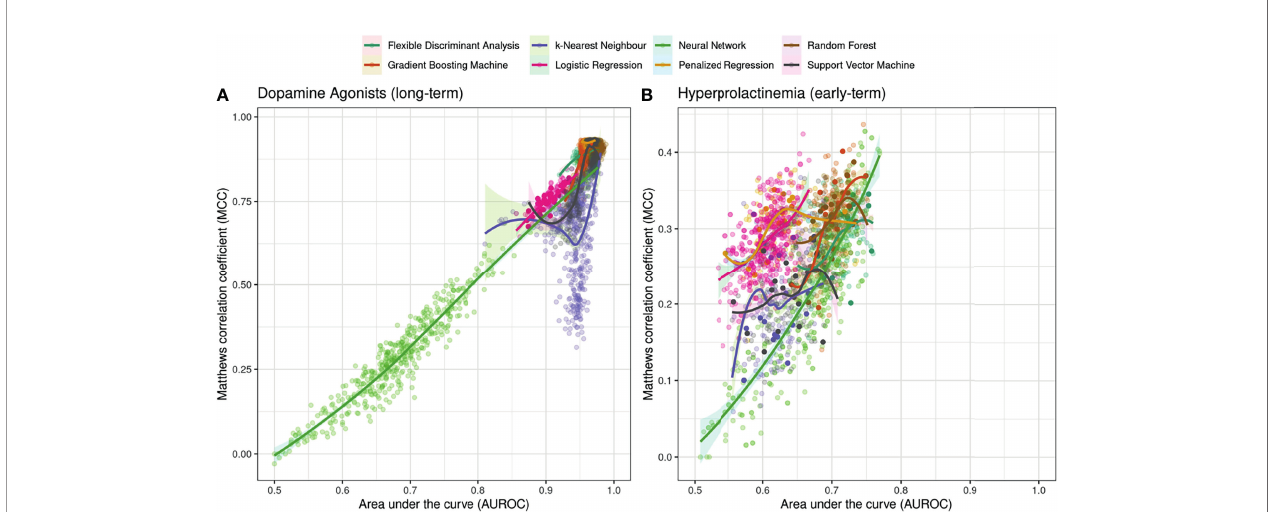
FIGURE 2 | Relationship between two performance metrics in a set of supervised classi fi cation algorithms resulting from randomly sampling two hyperparameters in each algorithm (N=500 samples). The area under the curve (AUROC) performance indicator is shown on the abscissa, whereas the corresponding value for the Matthews correlation coef fi cient (MCC) is shown on the ordinate. The outcomes are (A) dependency on DA on long-term follow-up and (B) successful control of hyperprolactinemia at early follow-up. For illustration purposes, a Locally Weighted Scatterplot Smoothing (LOESS) curves with associated 95% con fi dence intervals are shown for each classi fi cation algorithm.